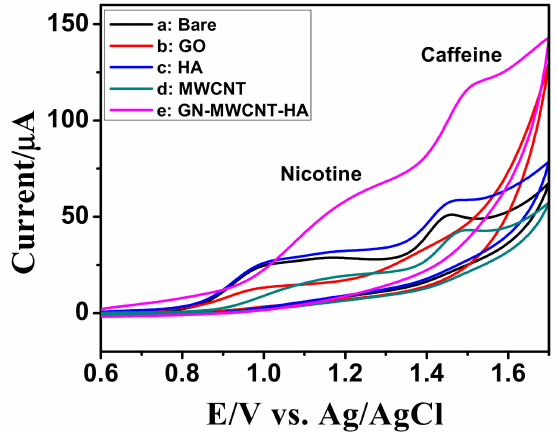
Figure 7. CVs obtained for the mixture of 1mM of nicotine and ca ff eine in 0.1 M PBS (pH 7.0) at modified GCEs at a scan rate of 50 mV s − 1 .